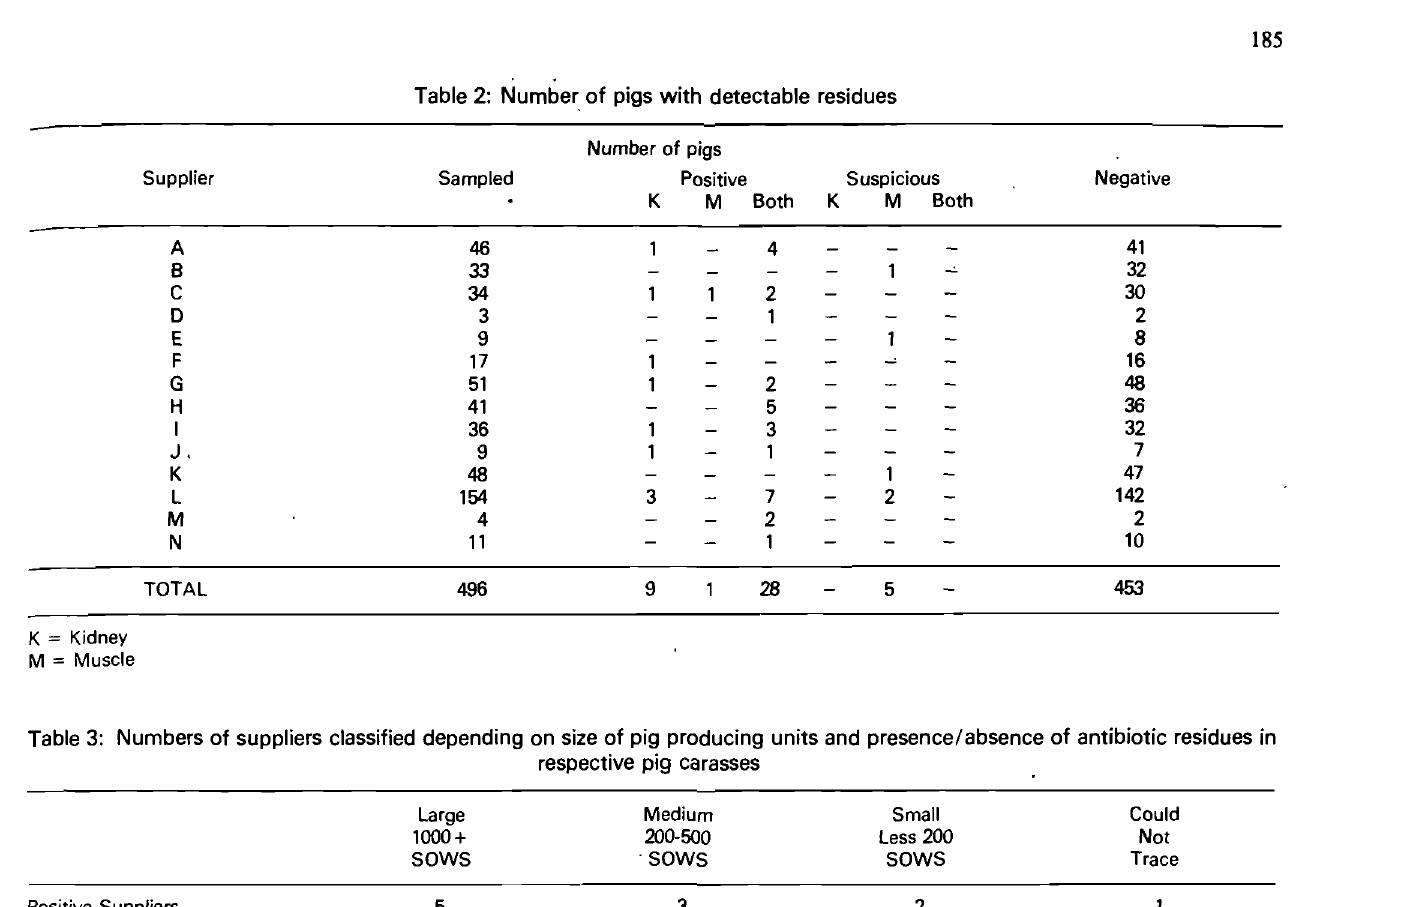
Table 4: Druys administered to pigs Drug